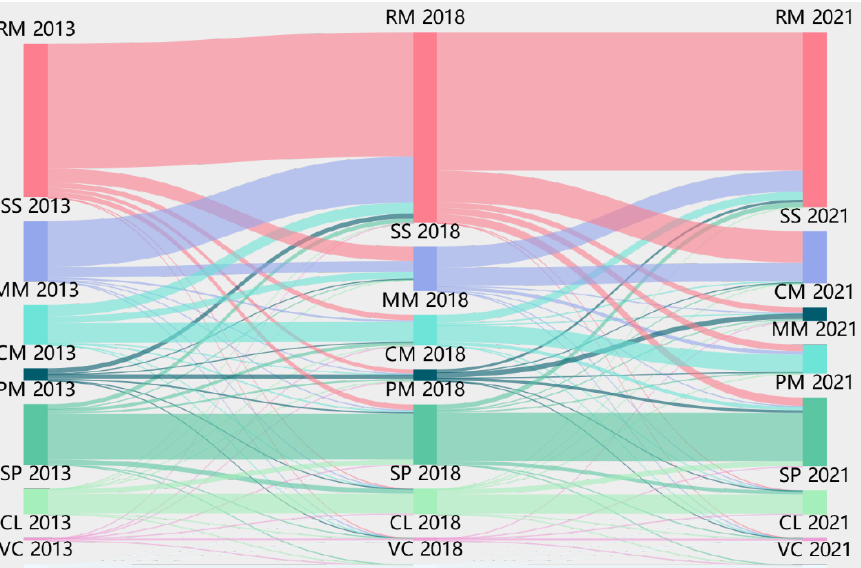
Figure 5. Illustration of transitions among mariculture types in Zhao’an Bay from 2013 to 2021. RM: raft mariculture, SS: seawater surface, MM: mudflat mariculture, CM: cage mariculture, PM: pond mariculture; SP: salt pan, CL: construction land, VC: vegetation cover.